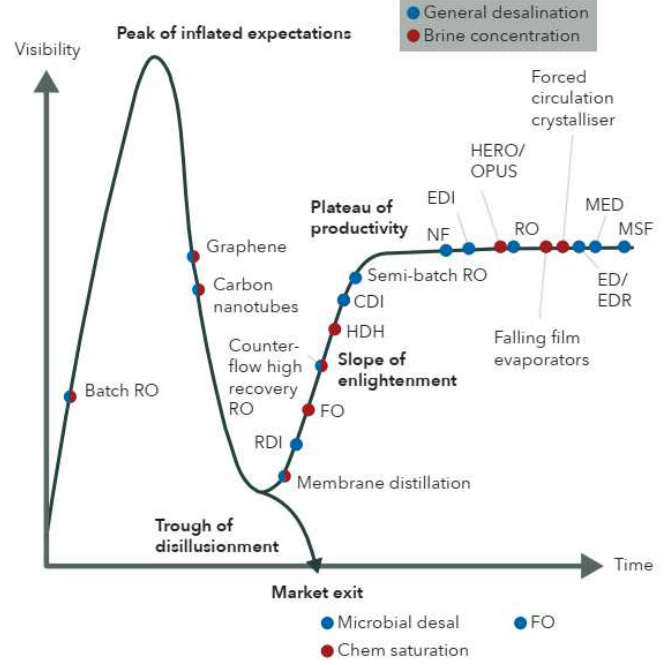
Figure 3. The commercialisation of innovative desalination and brine concentration technologies [59].